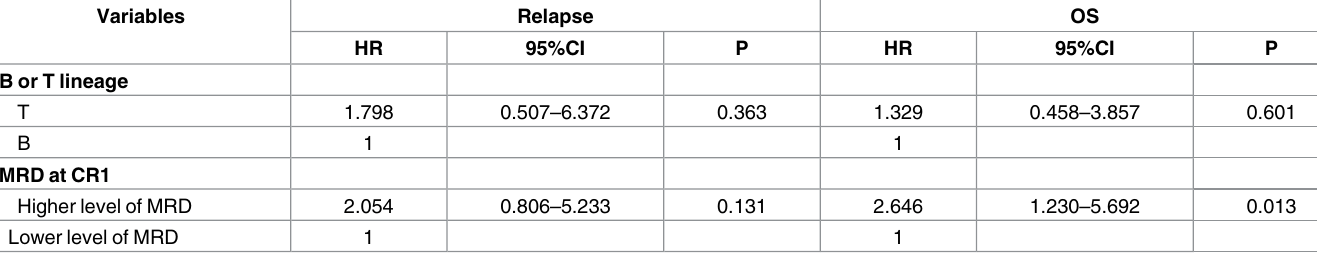
Table 3. Multivariate analysis for relapse and OS in the allo-HSCT